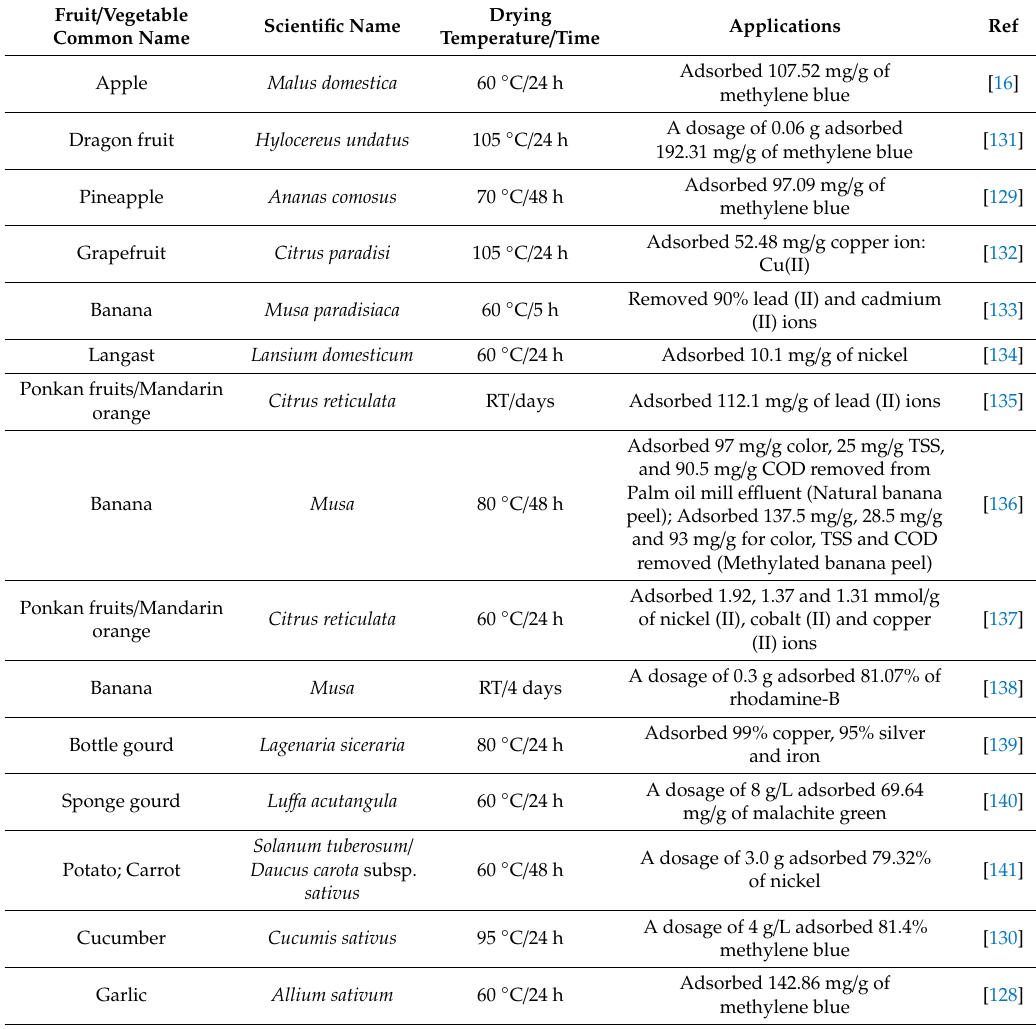
Table 6. Fruits and vegetables peel derived biosorbents and their